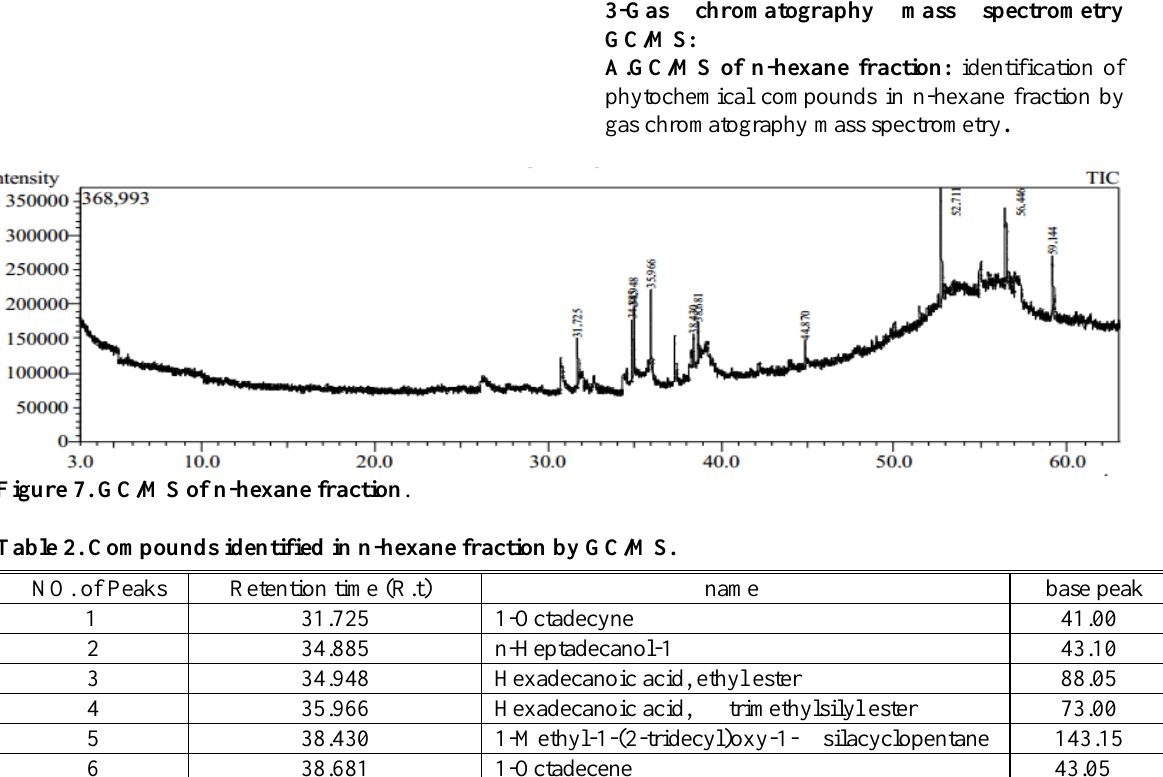
before hydrolysis with different titration under UV 254 nm to isolate AS1.